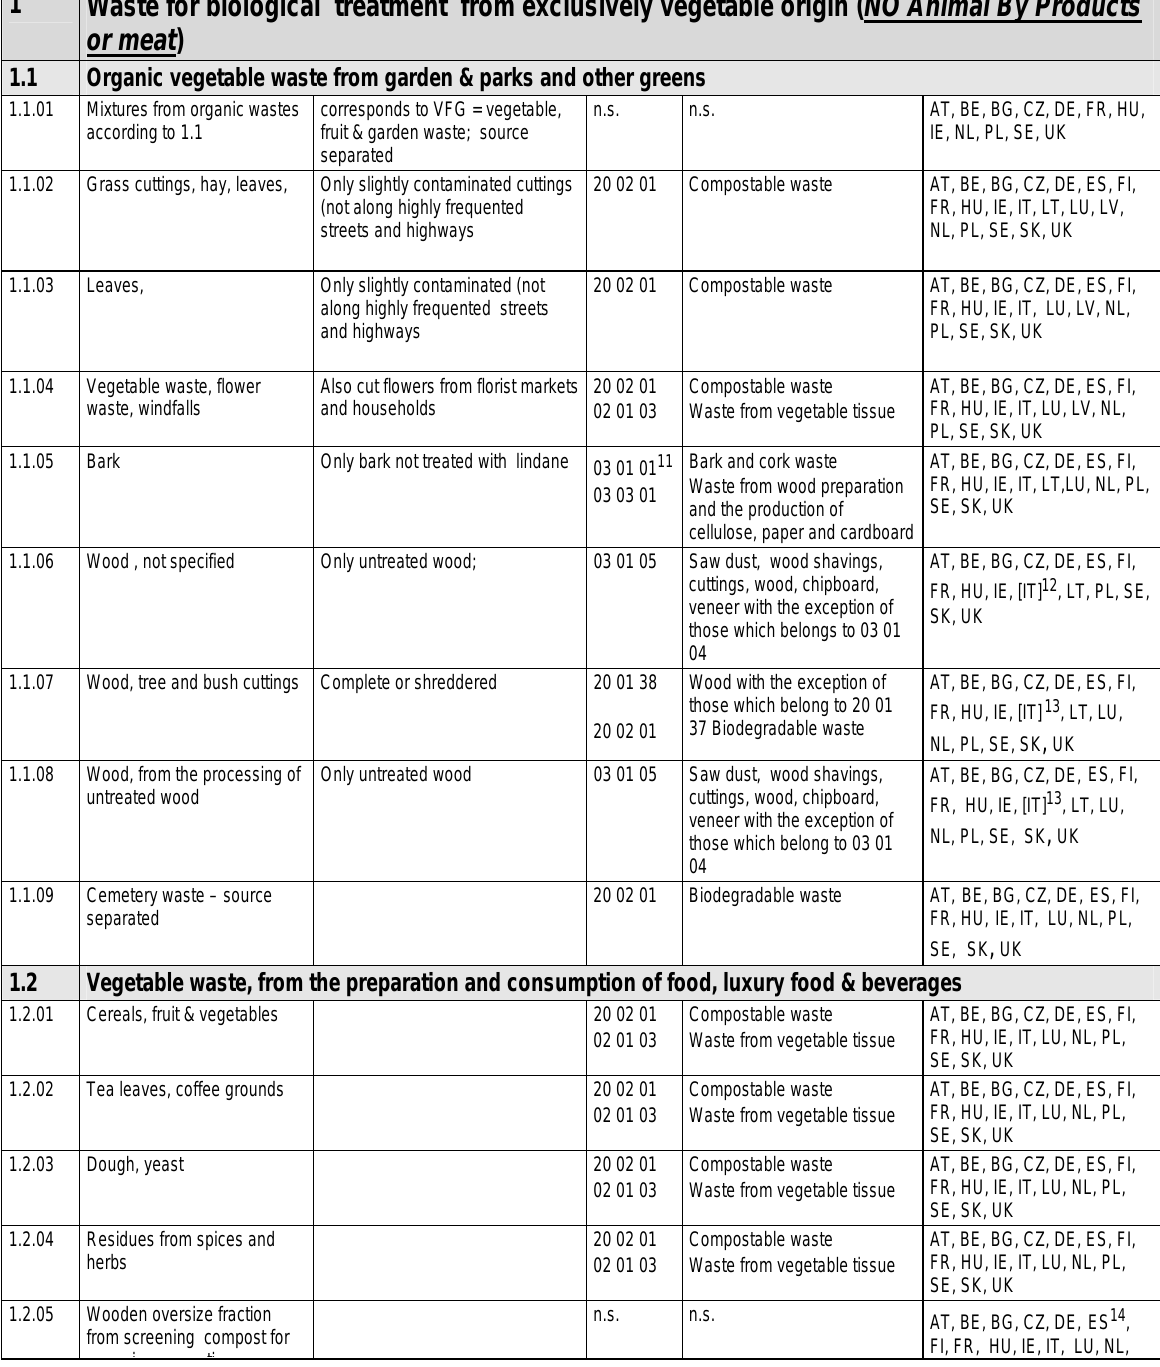
Table 5: Comparative list of waste materials allowed for the production of compost in EU Member States independent of waste or non-waste regime [AT] Countries in […] indicate that the use of this waste as input material for composting is connected with certain restrictions for marketing and use or that specific quality requirements must be met. See also